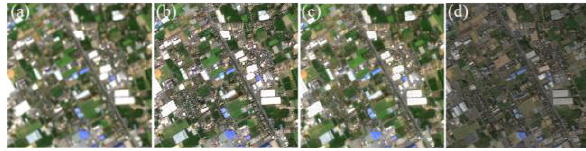
Figure 15 . Comparison EXP1&2 test results for S2 (a) GR 10m input (b) EXP1 model output (c) EXP2 model output and (d) Google Earth HR image taken at 2015/10/8.